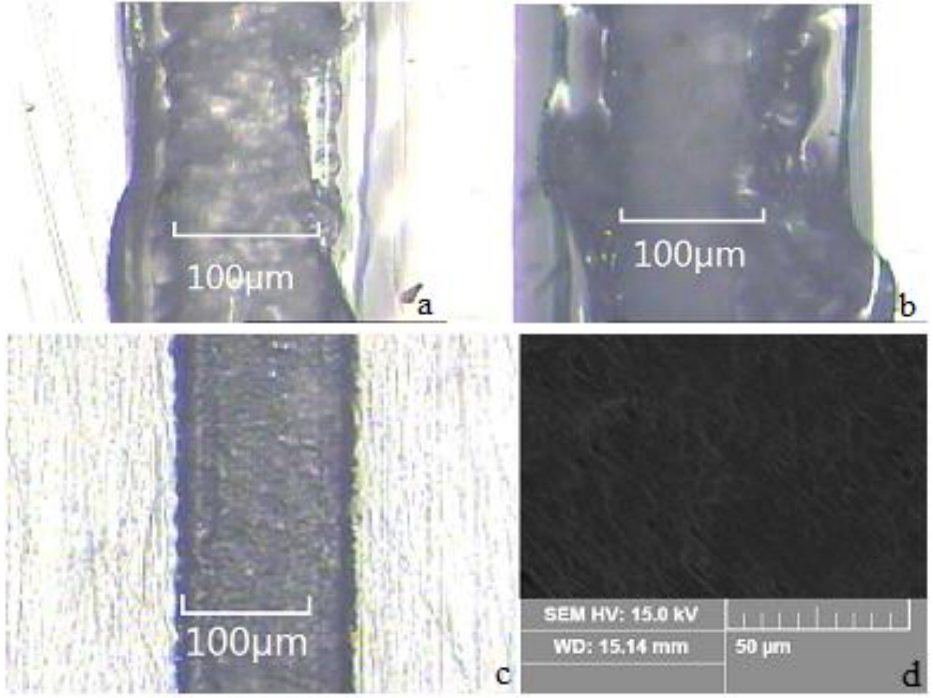
Figure 10. Microchannels under different fabrication conditions. ( a ) A microchannel fabricated without heating; ( b ) A microchannel fabricated at 133 °C; ( c ) A smooth microchannel fabricated with an engraving velocity of 4.2 mm/s and a temperature of 93 °C; ( d ) Details of the bottom of the smooth microchannel.